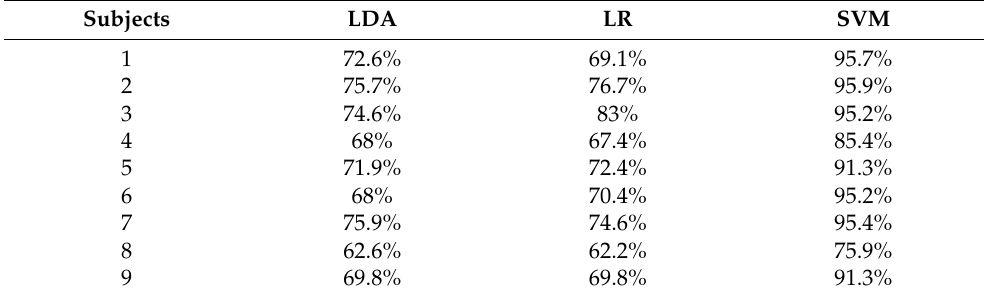
Table 2. Subject-wise classification accuracies of all subjects (%) were obtained by implementing LASSO homotopy for channel selection of HbO signals and classification using SVM, LDA, and LR of the walking and resting states (binary classification) of 9 subjects.